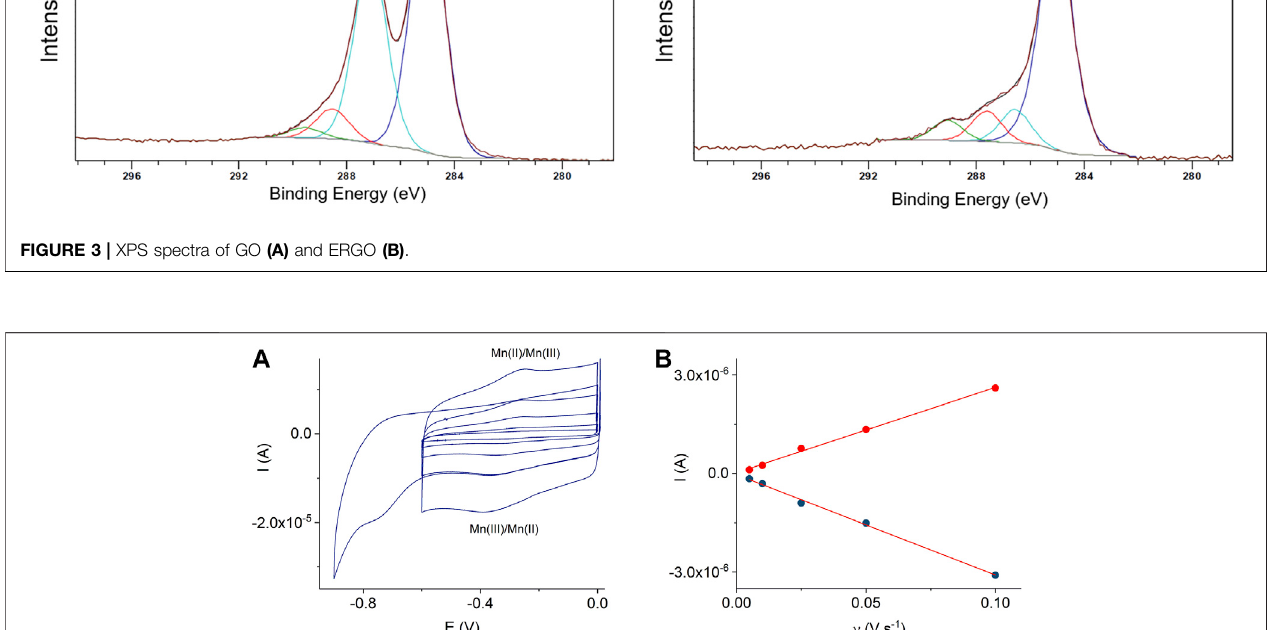
Frontiers in Chemistry |